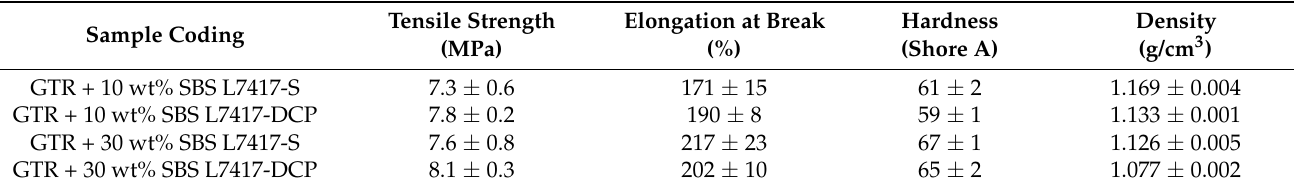
Table 3. Physico-mechanical properties of GTR modified by SBS and cross-linking agents. Sample